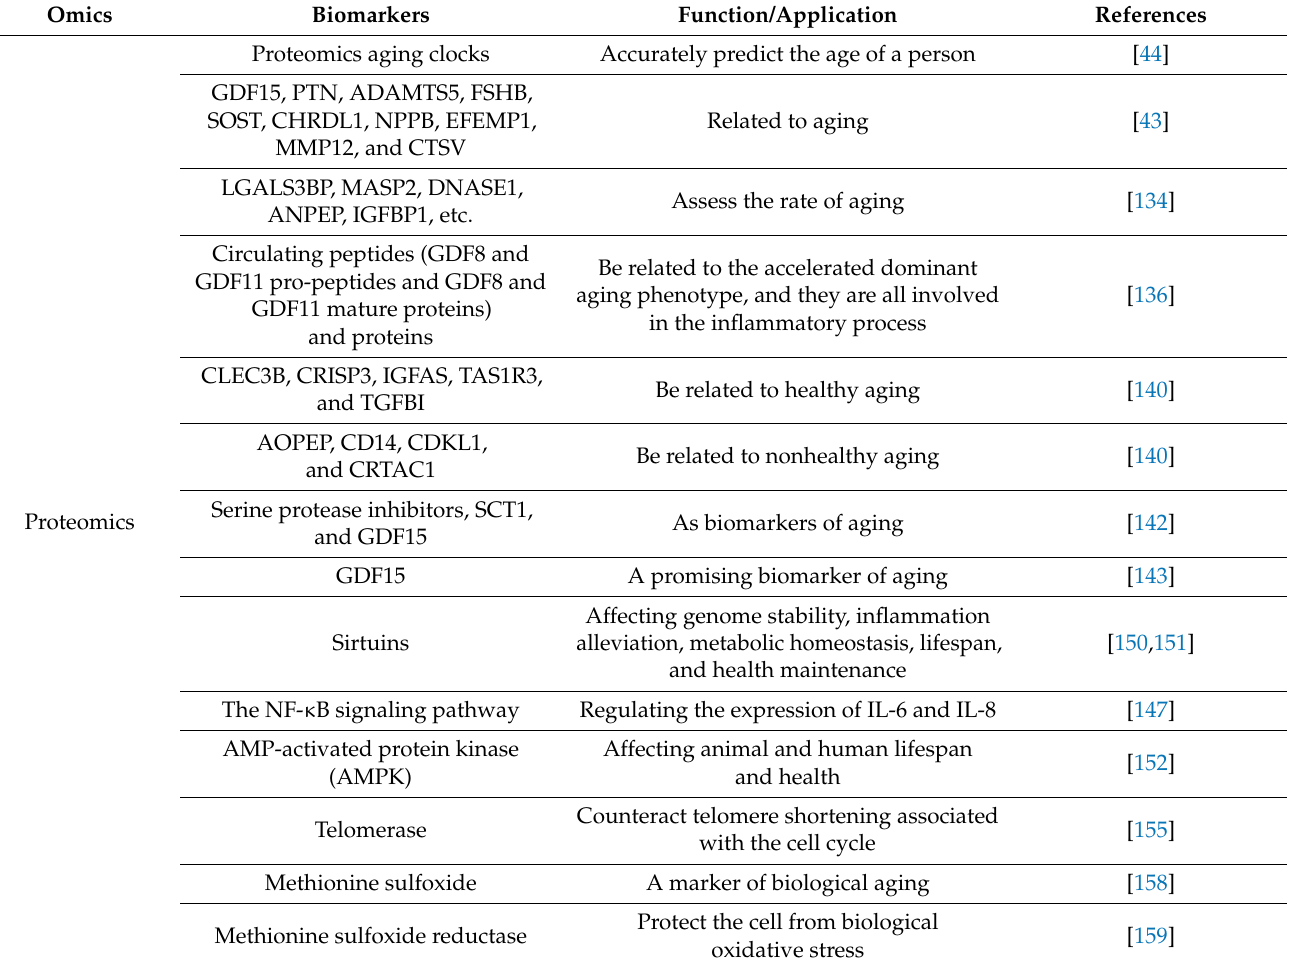
Table 3. Potential aging biomarkers identified in proteomics